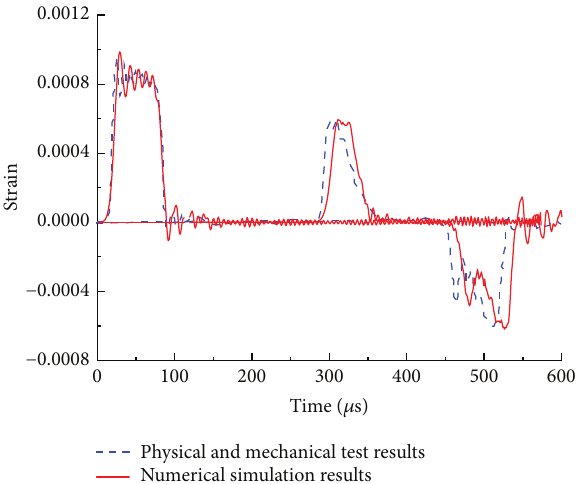
Figure 3: Comparison of numerical and experimental stress wave waveforms for SHPB impact